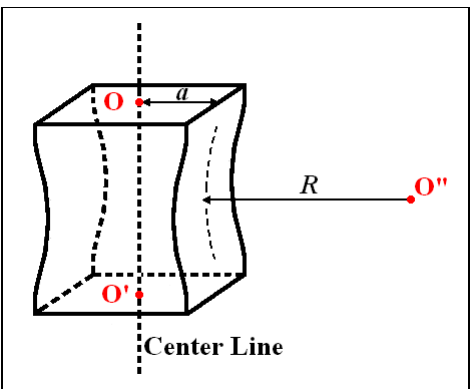
Figure 16. Neck region of a tensile